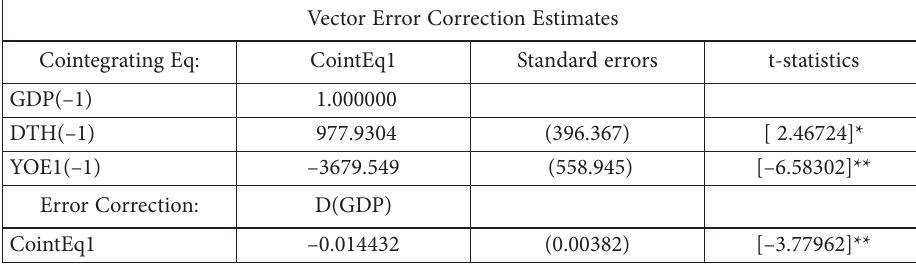
Table 8. Estimation and validation of the main parameters of the cointegration model for Cluster A Vector Error Correction Estimates